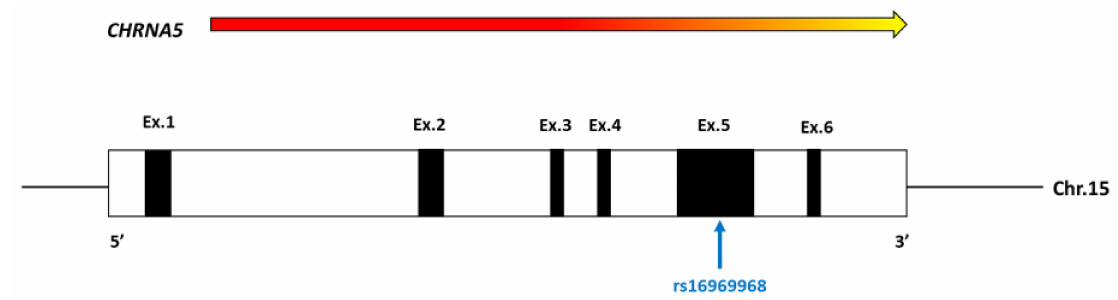
Figure 2. Scheme of the CHRNA5 gene. The black rectangles represent the exons, and the white rectangles represent the untranslated regions. A colored arrow indicates the direction of